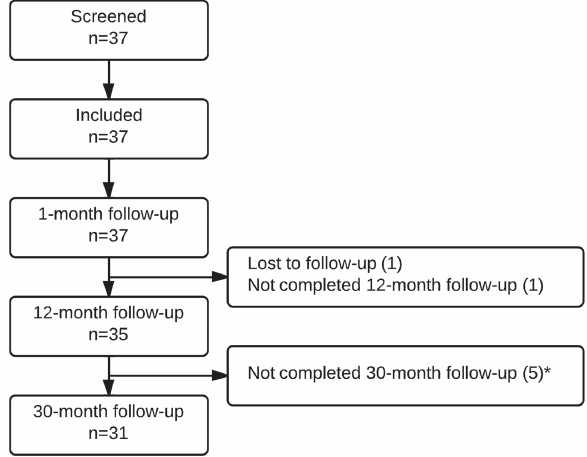
Figure 5 - Study subjects’ distribution tree.